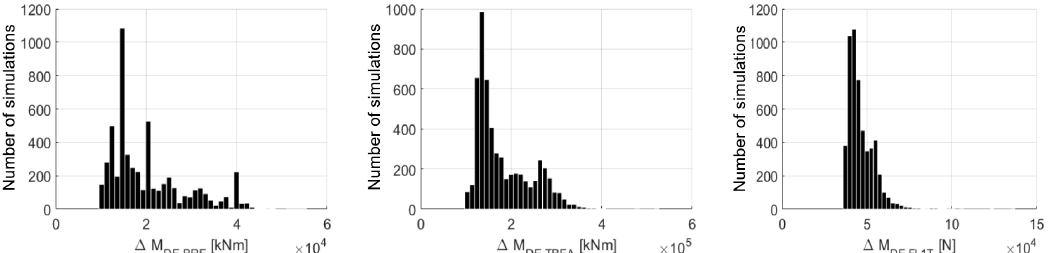
Figure 7. Histograms of simulated DELs for different